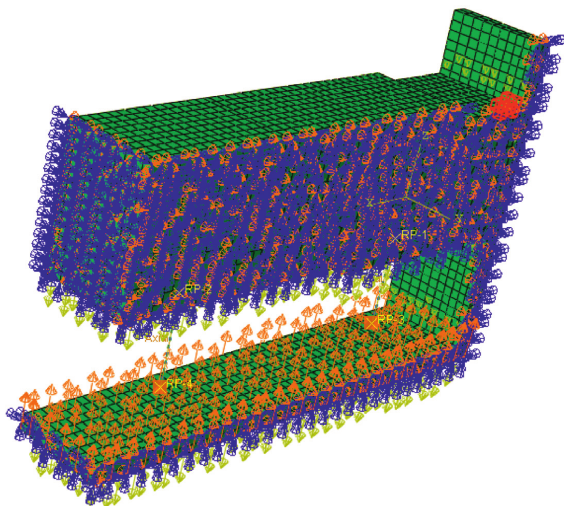
Figure 8: Model boundary condition.